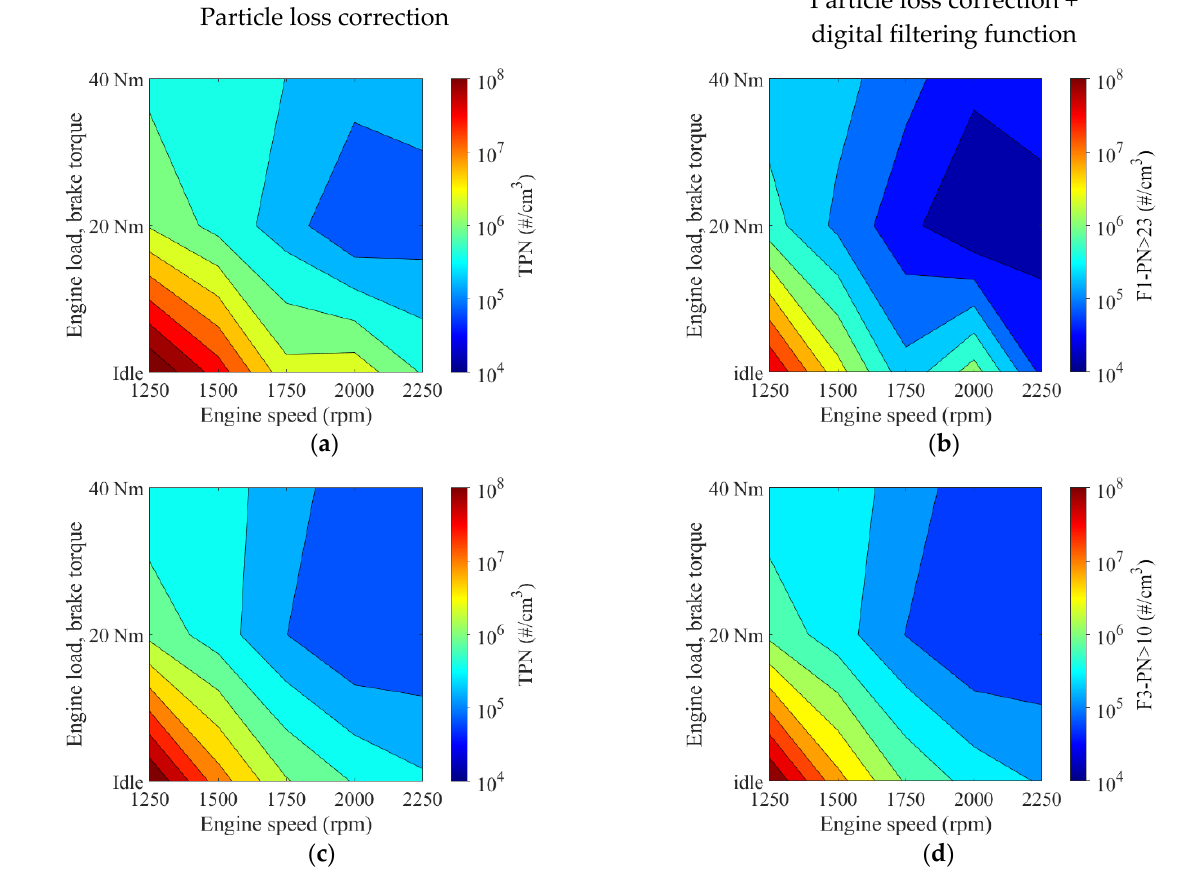
Figure 5. Total particle number (TPN) by engine speed and load for DMS measurements with and without catalytic stripper (CS) in subfigures ( c , d ) and ( a , b ), respectively. The data displayed in subfigures ( a , c ) has been particle loss corrected. The data displayed in subfigures ( b , d ) has been digitally filtered in addition to the particle loss correction. For the digital filtering, Equation (1) was applied for F1-PN > 23 and Equation (3) for F3-PN > 10.